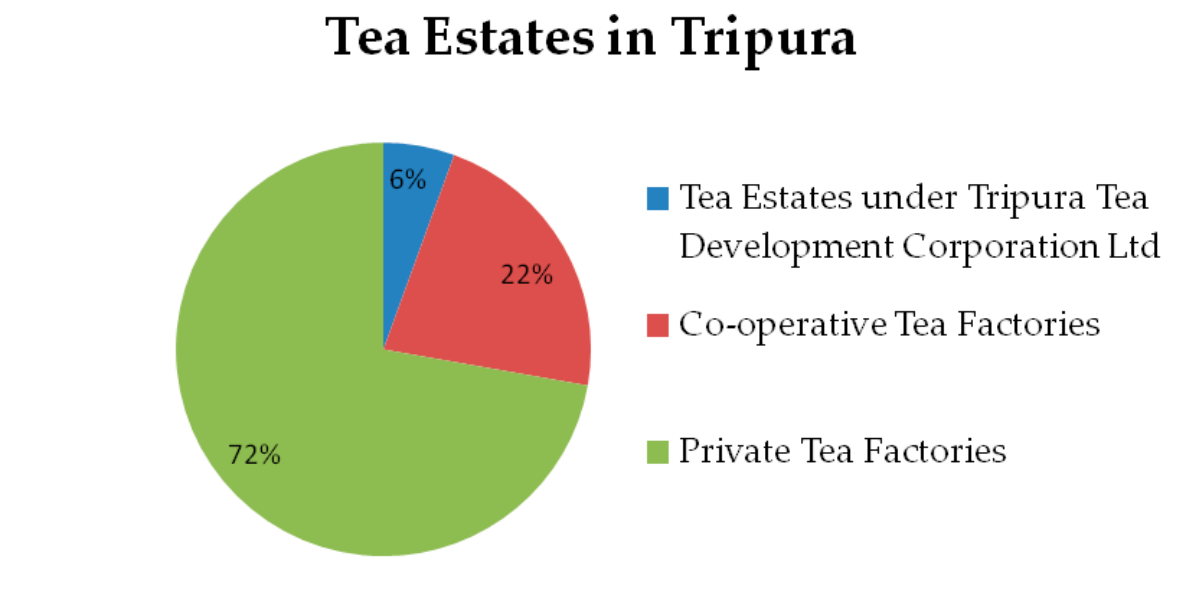
Table 2. Position of functioning Tea Factories. Sl.No.